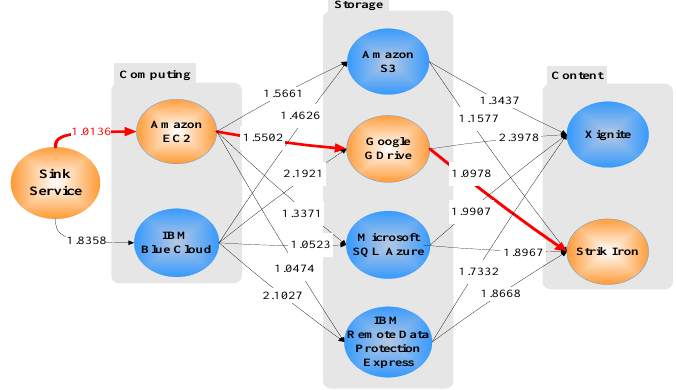
Figure 4. QASM generate the consistent resource shortest service